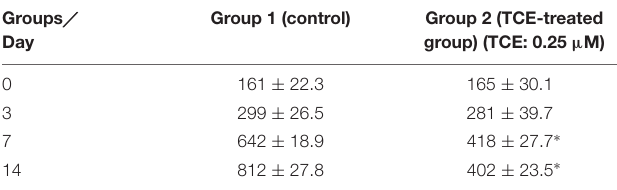
TABLE 1 | Neurospheres diameter (proliferation) in the studied